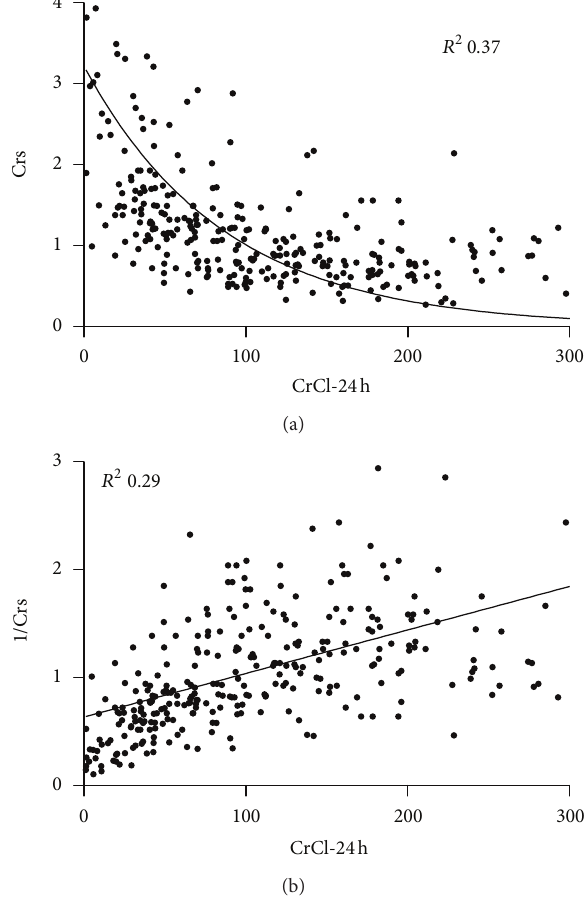
Figure 2: Relationship between serum creatinine and creatinine clearance. Data from the authors, adapted from